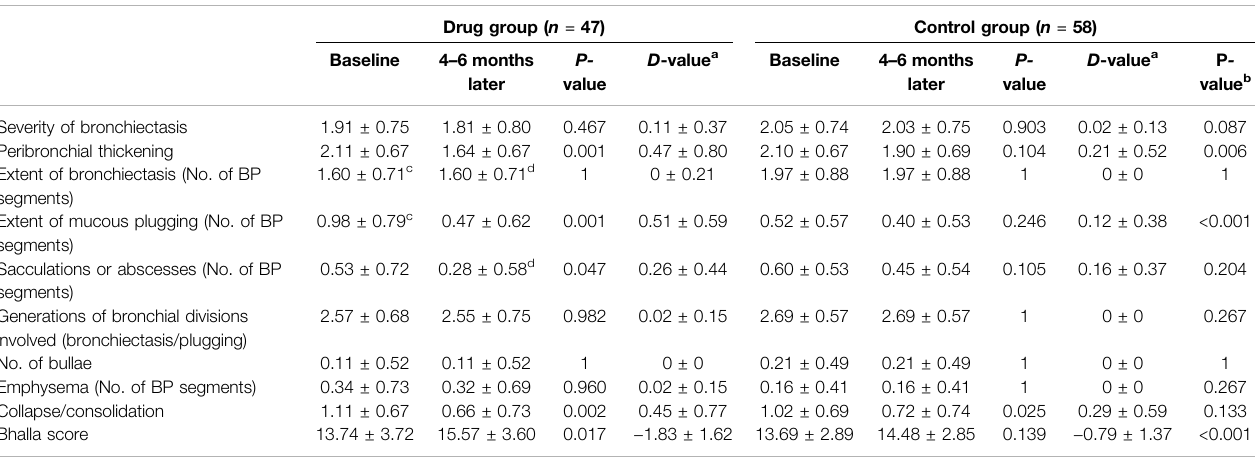
TABLE 3 | Comparison of HRCT within 4 – 6